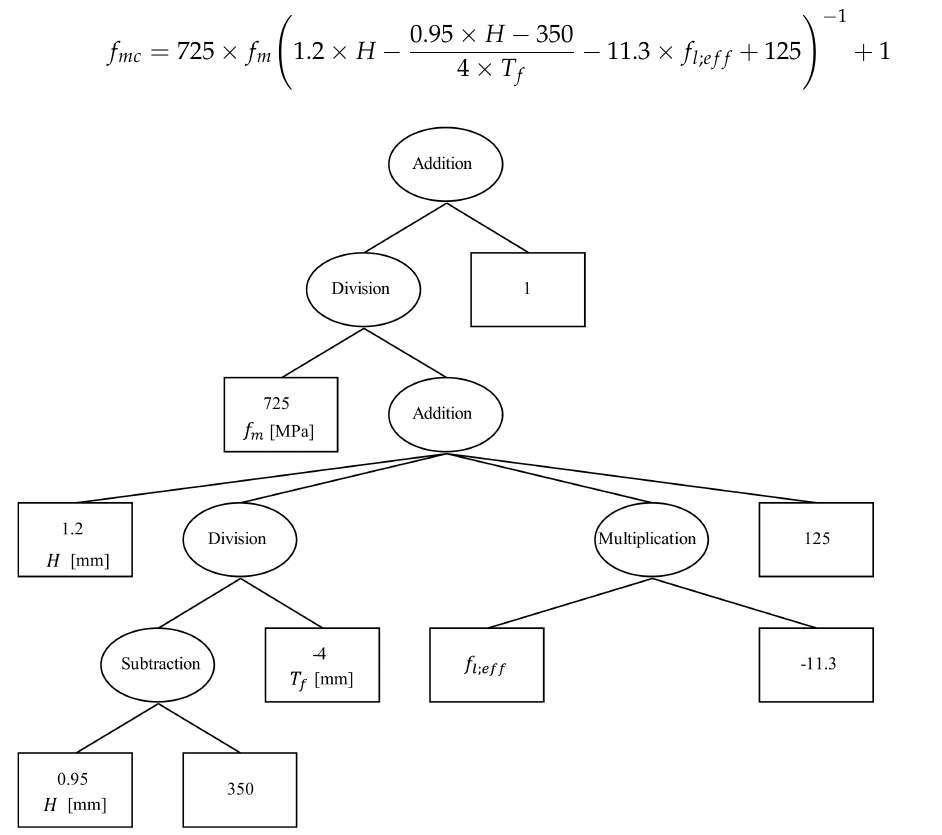
Figure 8. Simplified symbolic expression